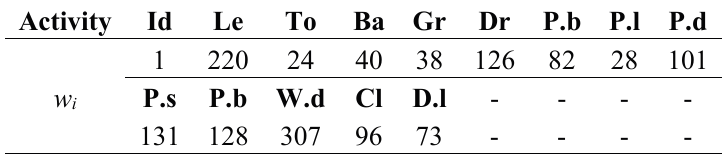
Table 5. Selection of the weights w i using TAP30F dataset.